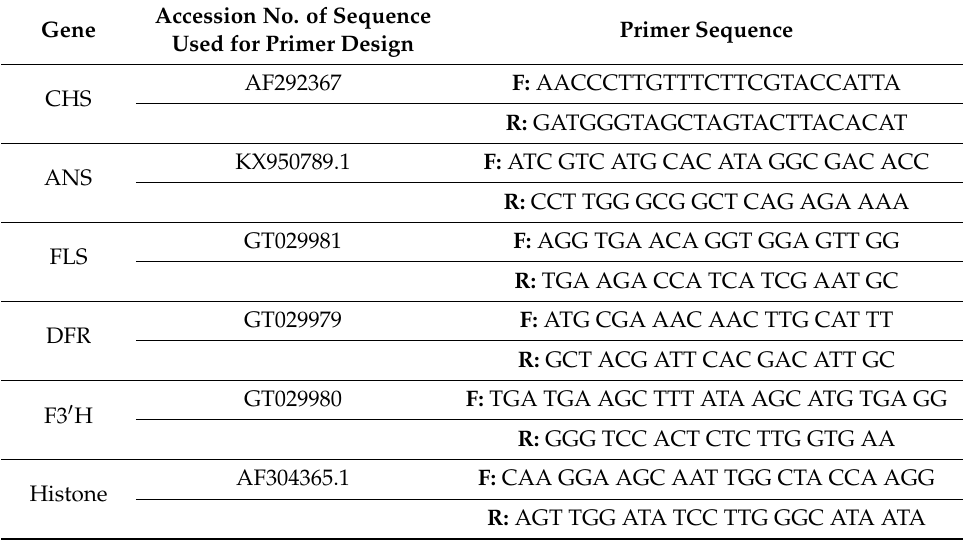
Table 4. The sequences of the primer used for RT-PCR